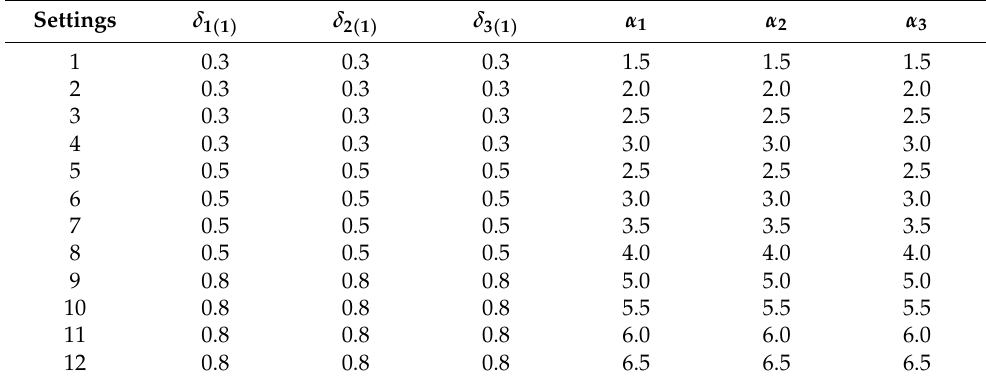
Table 1. Simulation study parameter settings for δ i ( 1 ) , α i , and β i = 1 with k = 3.